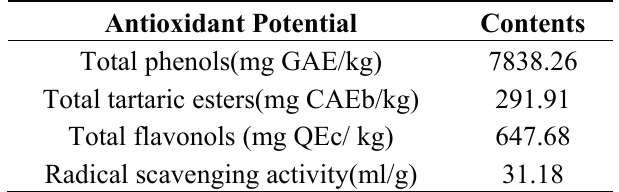
Table 15. Antioxidant potential of blackberry fruits [40].